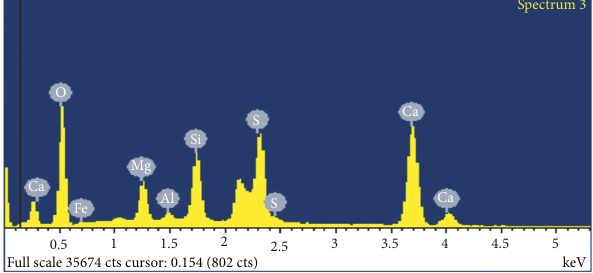
Figure 11: EDX on the border to the specimen of